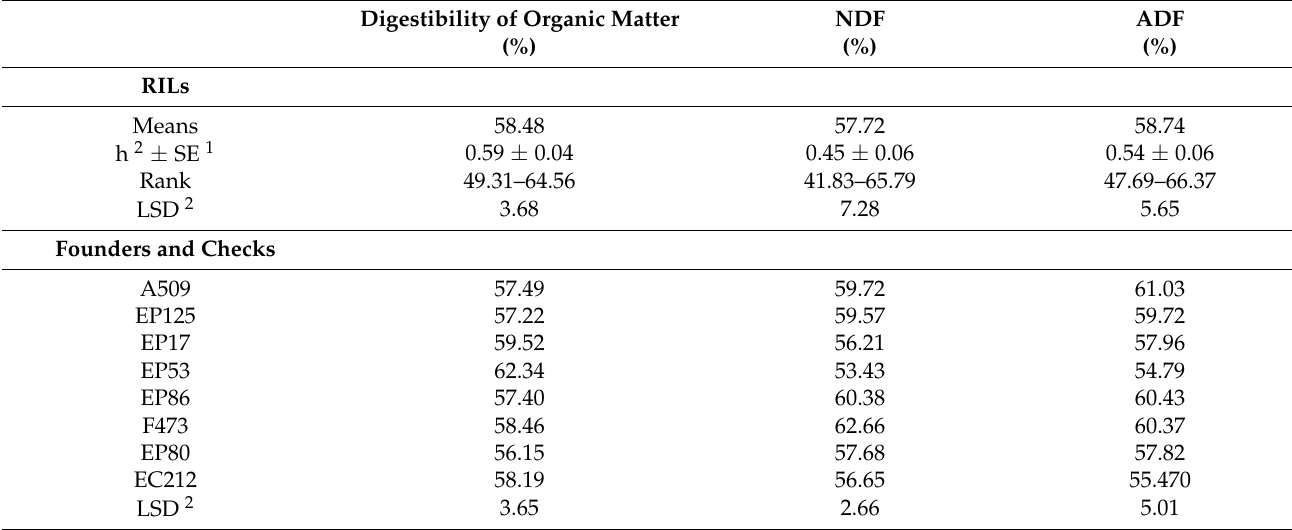
Table 2. Means, heritability and rank of RILs from a MAGIC population and means of inbred checks for forage digestibility and fiber contents evaluated in two years. Digestibility of Organic Matter